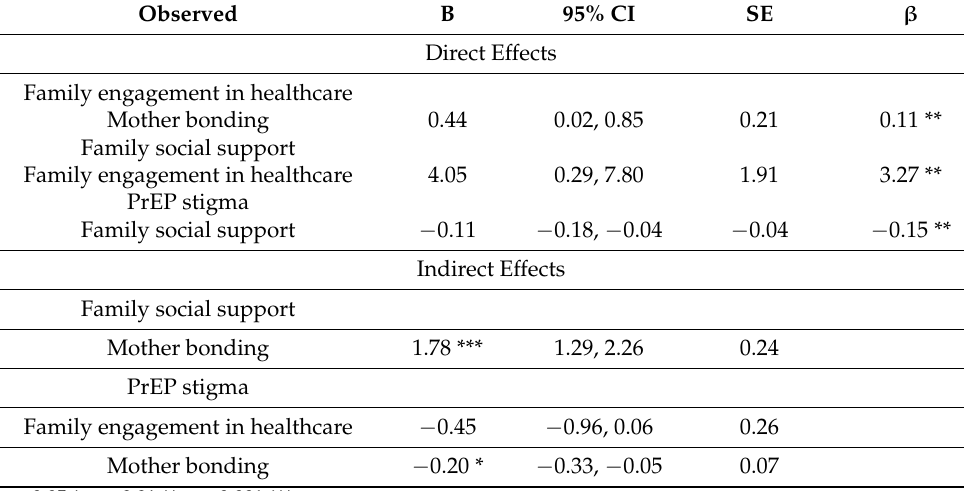
Table 3. Path Analysis Mother Bonding on PrEP Stigma ( n = 399).